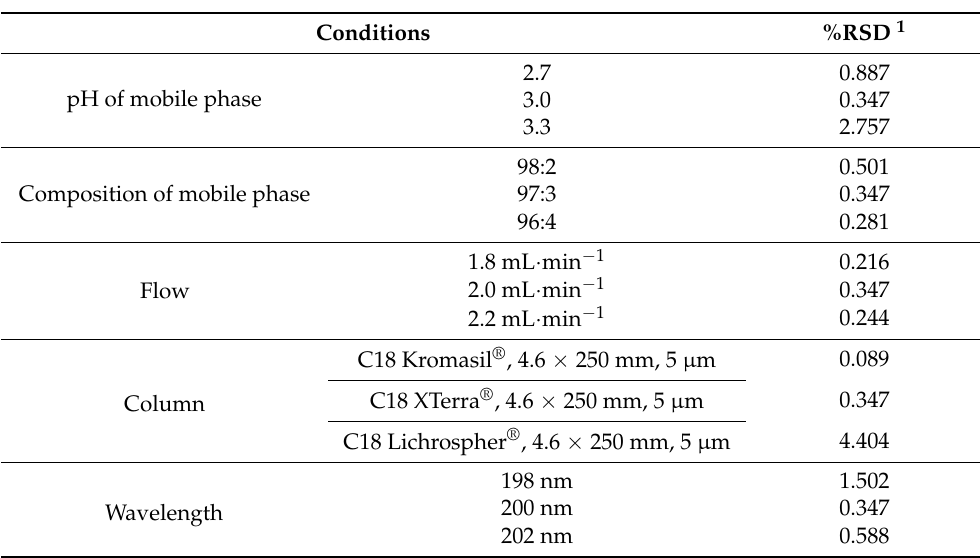
Table 2. Robustness.